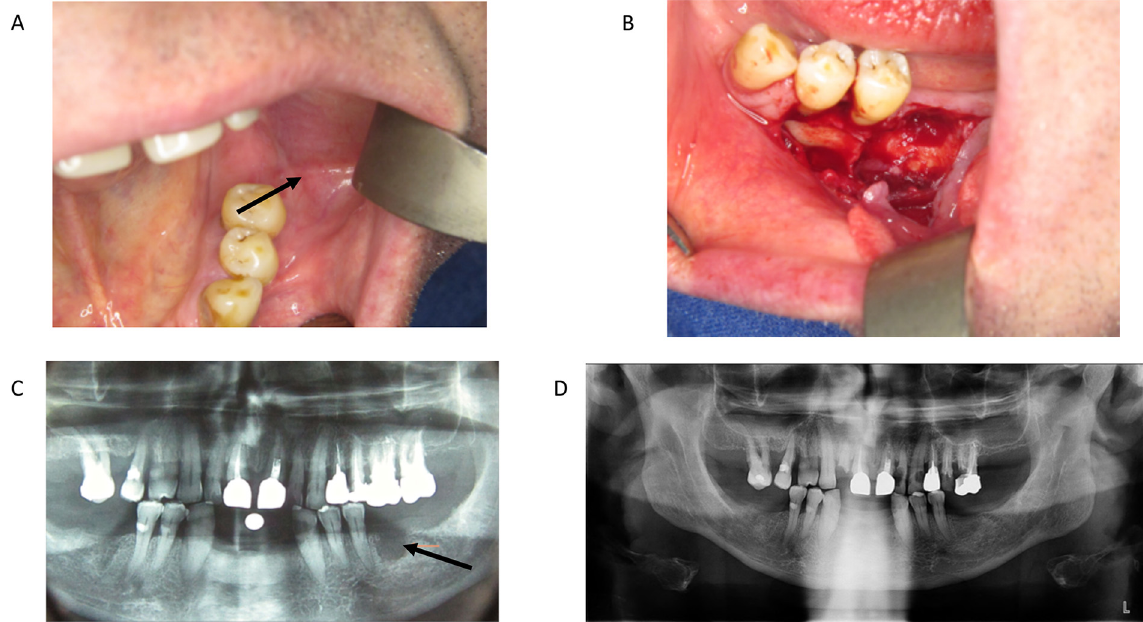
Fig. 2. (A) Preoperative view with gingival swelling. (B) Intraoperative view of the intervention after exeresis of the Lesion and preservation of the mental nerve. (C) Panoramic tooth fi nding an osteolytic lesion of mixed, uniloculated and well circumscribed appearance. (D) Panoramic tooth at 5 years fi nding no